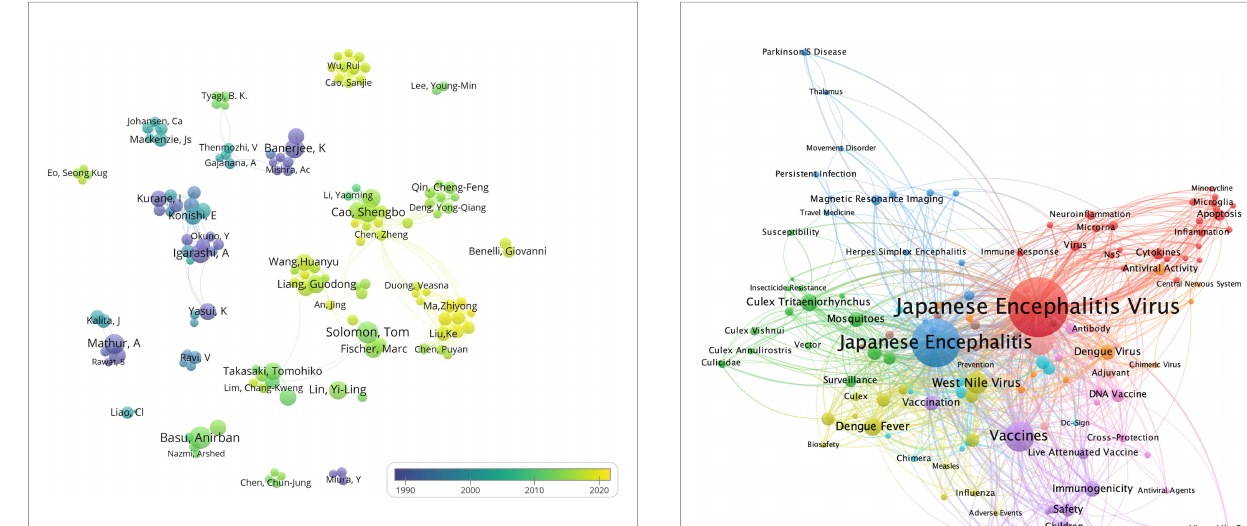
FIGURE 2 | Author co-authorship analysis map. The size of each node indicates the number of publications produced by the author. The thickness of each link indicates the strength of collaboration relationship between two authors. The distance between two nodes indicates the relatedness of the links they each has. Indicator shows the publication time of the author from purple to yellow.